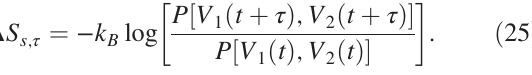
FIG. 9. (a) Equilibrium: P ð W E , where E stands for either W or Q . Notice that when the system is in equilibrium, P ð W 1 (b) Out of equilibrium: Same distributions as in (a) but the PDFs are measured at T 1 ¼ 88 K, T 2 ¼ 296 K, and τ ¼ 0 . 1 s . Notice that when the system is out of equilibrium, P ð W 1 text. (c) The symmetry function Sym ð E 1 these straight lines is T 2 =T 1 − 1 . (d) The temperature T measured by the thermometer. The slope of the line is 1, showing that T